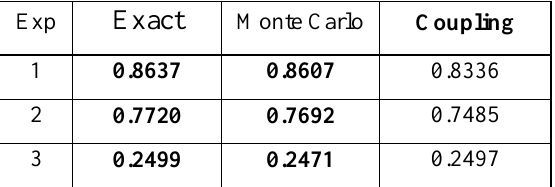
Table 1. Average outputs for a station in isolation.